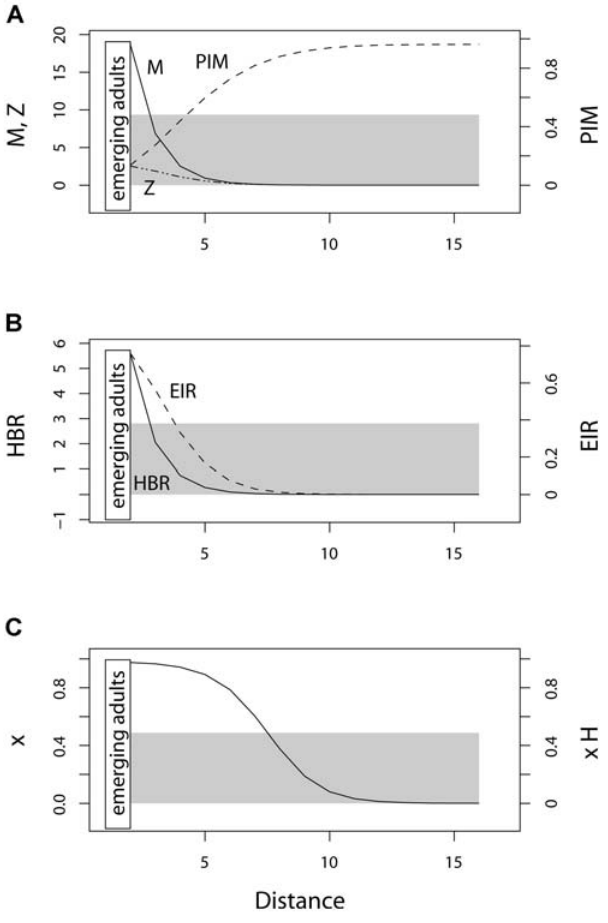
Figure 3. Statics with Heterogeneous Humans and Homogeneous Mosquitoes HBR and EIR reflect mosquito movement and human distribution patterns when larval habitat is evenly distributed but humans have a low–high–medium distribution, such as a town with rural and suburban populations on either side (the gray background illustrates the human distribution). (A) Mosquito density (solid) is highest in town, peaks at the edges of town, and dips just outside of town. PIM (dashed) and the density of infected mosquitoes ( Z, dotted) follow similar patterns. (B) HBR (solid) and EIR (dashed) are both high on the low-density side of town and lowest on the medium-density side of town, with peaks just inside town and troughs just outside of town. (C) The density of infected humans (dashed) and the prevalence of infection in humans (solid) peak at the edge of town, but prevalence of infection in humans is less variable than HBR or EIR. DOI: infection in humans is lowest overall in the patches with low human density (Figure 3C). This model also makes the surprising prediction that the risk of infection is lowest just outside the edge of town: the sharp difference in human density at the edge leads to a strong tendency for mosquitoes to be drawn into, rather than away from, town, decreasing HBR and PIM (Figure 3B and 3C). Heterogeneous Larval Habitat and Human Population When mosquitoes and humans are distributed unevenly, the distribution of mosquitoes and risk may be dominated either by proximity to larval habitats and gradients away from